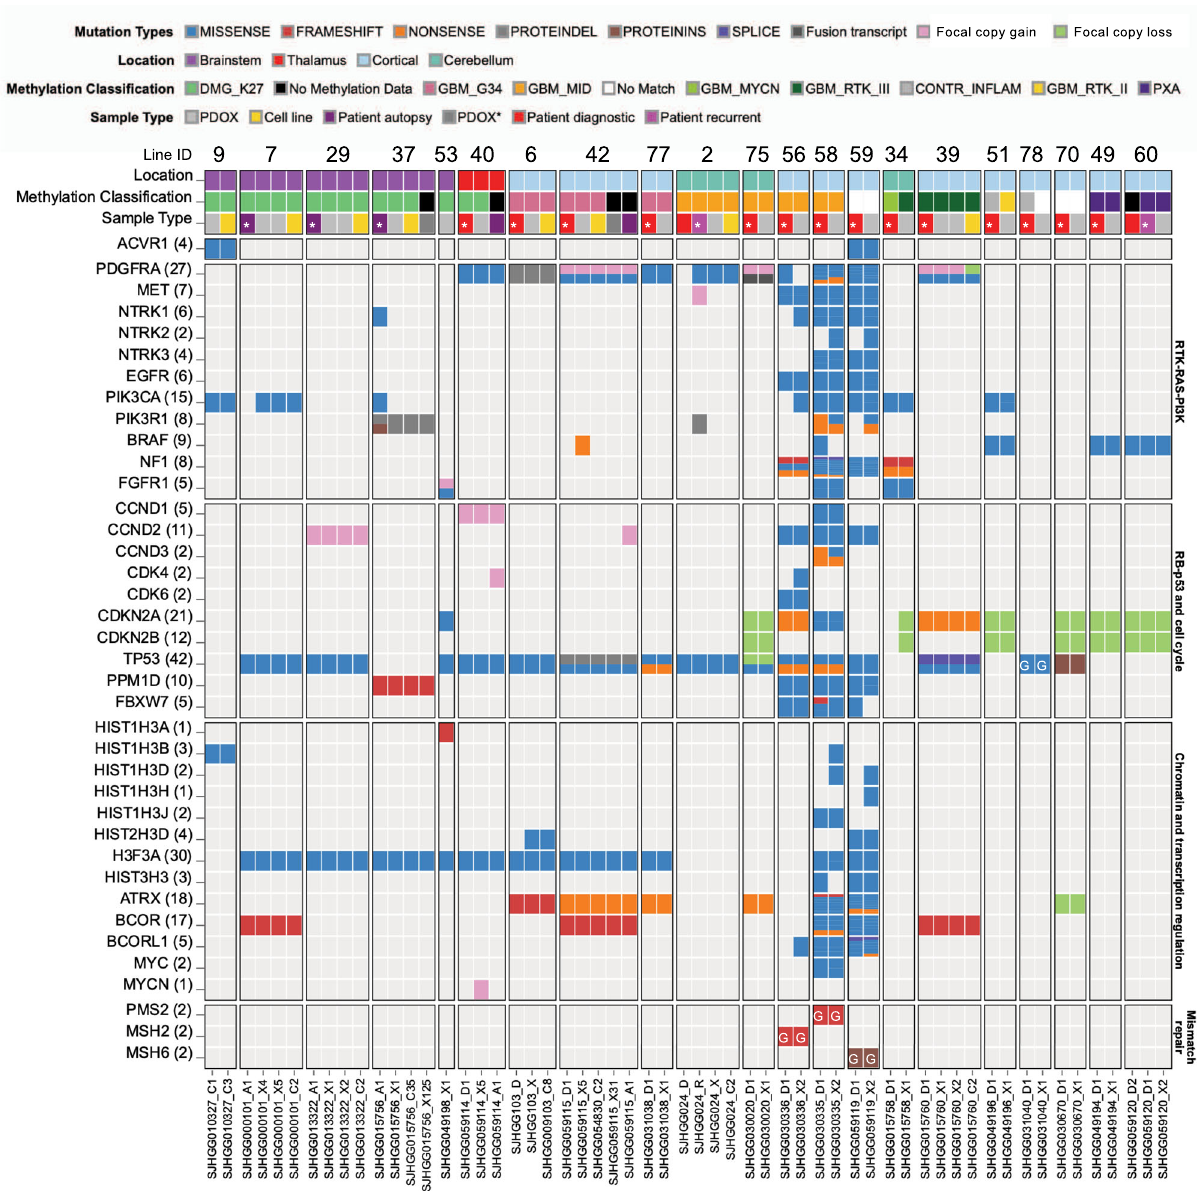
Fig. 4 Genomic landscapes of PDOX and cell lines conserve alterations present in the matched patient tumor and represent a variety of pHGG subtypes. Alterations in genes recurrently mutated in pHGG are indicated on the left. Pathways are indicated on the right. Columns show tumor samples. PDOX and cell lines are grouped together with patient tumors from which they were derived. Numbers are the PDOX identi fi er IDs across the top, sequence fi le IDs across the bottom. Rows show the location of patient tumors, DNA methylome classi fi cation, and tumor sample type. In some cases, patient tumor samples from recurrence or autopsy are included along with the diagnostic sample. Asterisk in tumor sample type indicates the patient tumor from which the PDOX was derived. For 7, passages 7 and 10 of SJ-DIPGX7 are shown, and for 29, passages 3 and 4 of SJ-DIPGX29 are shown. PDOX* (dark gray box) indicates xenograft generated by implanting the associated cell line. Mutations in signature genes shown as rows are indicated by Mutation Type color code. G in block indicates germline